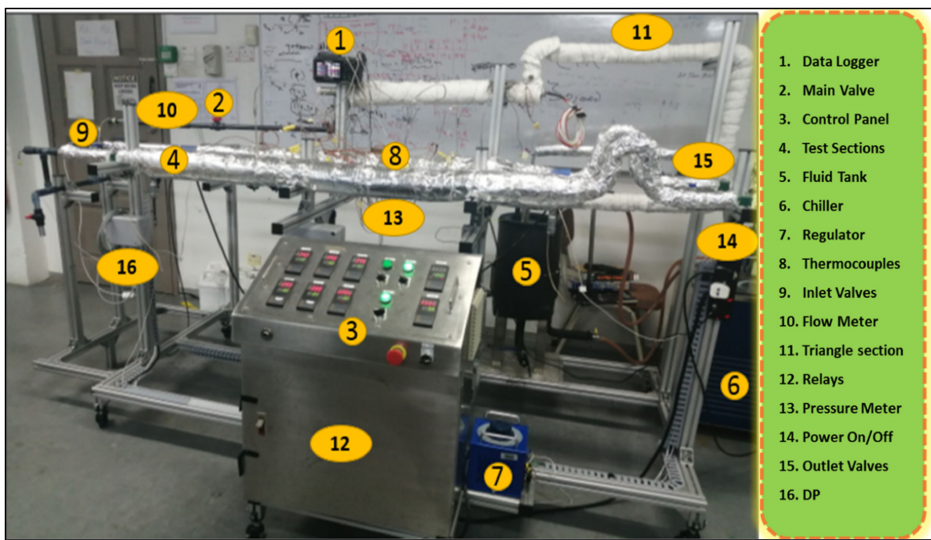
Figure 3. Experimental setup of a heat transfer test rig for studying heat transfer and friction loss.